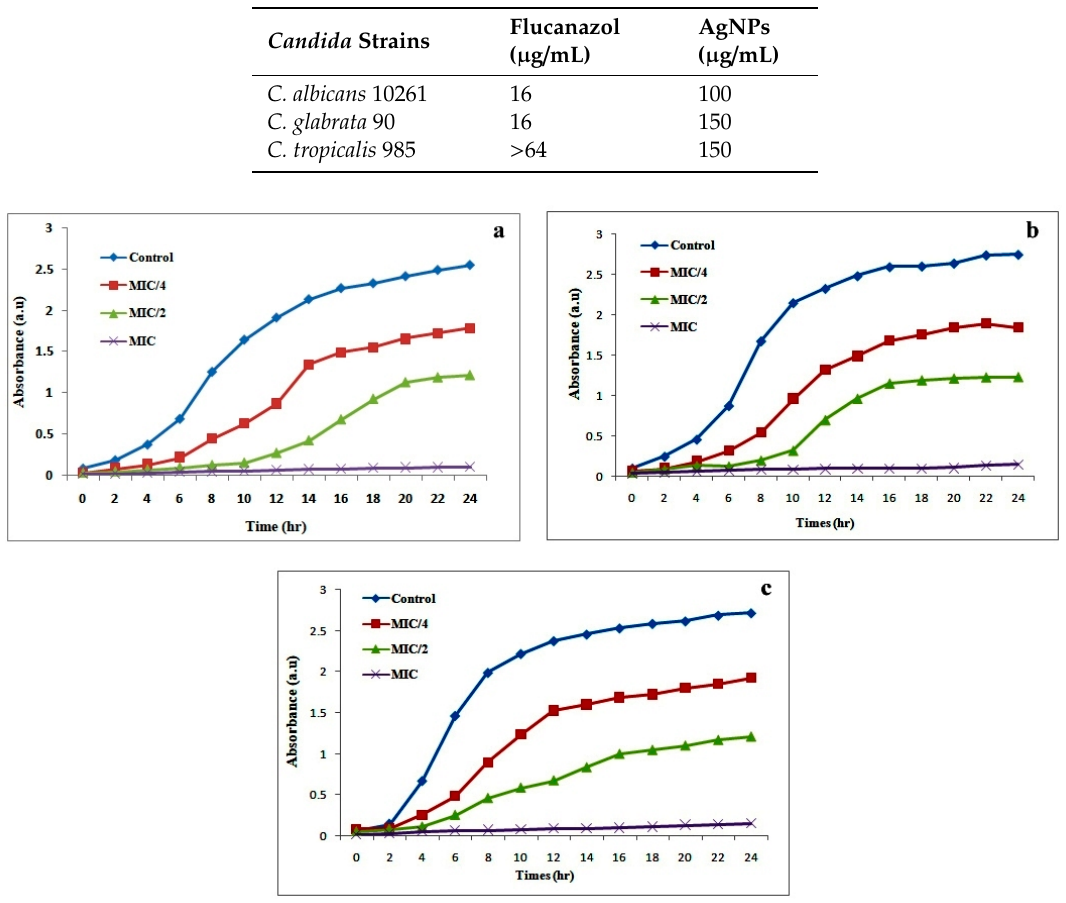
Table 3. Antifungal activity (MIC) of biosynthesized AgNPs against di ff erent Candida strains. Table 3 . Antifungal activity (MIC) of biosynthesized AgNPs against different Candida strains.